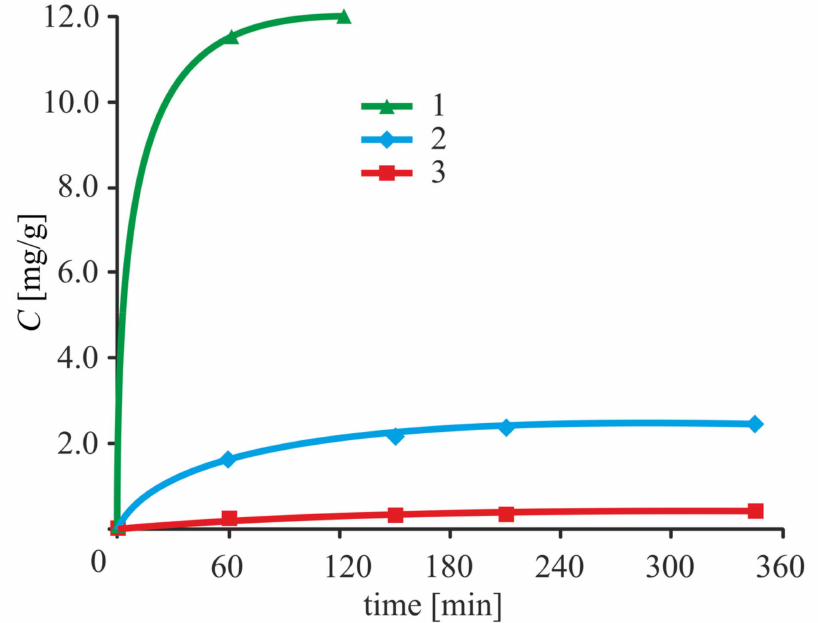
Figure 9. Dependence of the amount of adenosine ( C ) transferred to the solution from the surface of the nanoparticles, referring to a unit of weight in the desorption time for various immobilization methods: 1, adsorption; 2, covalent; and 3, ion binding [59].